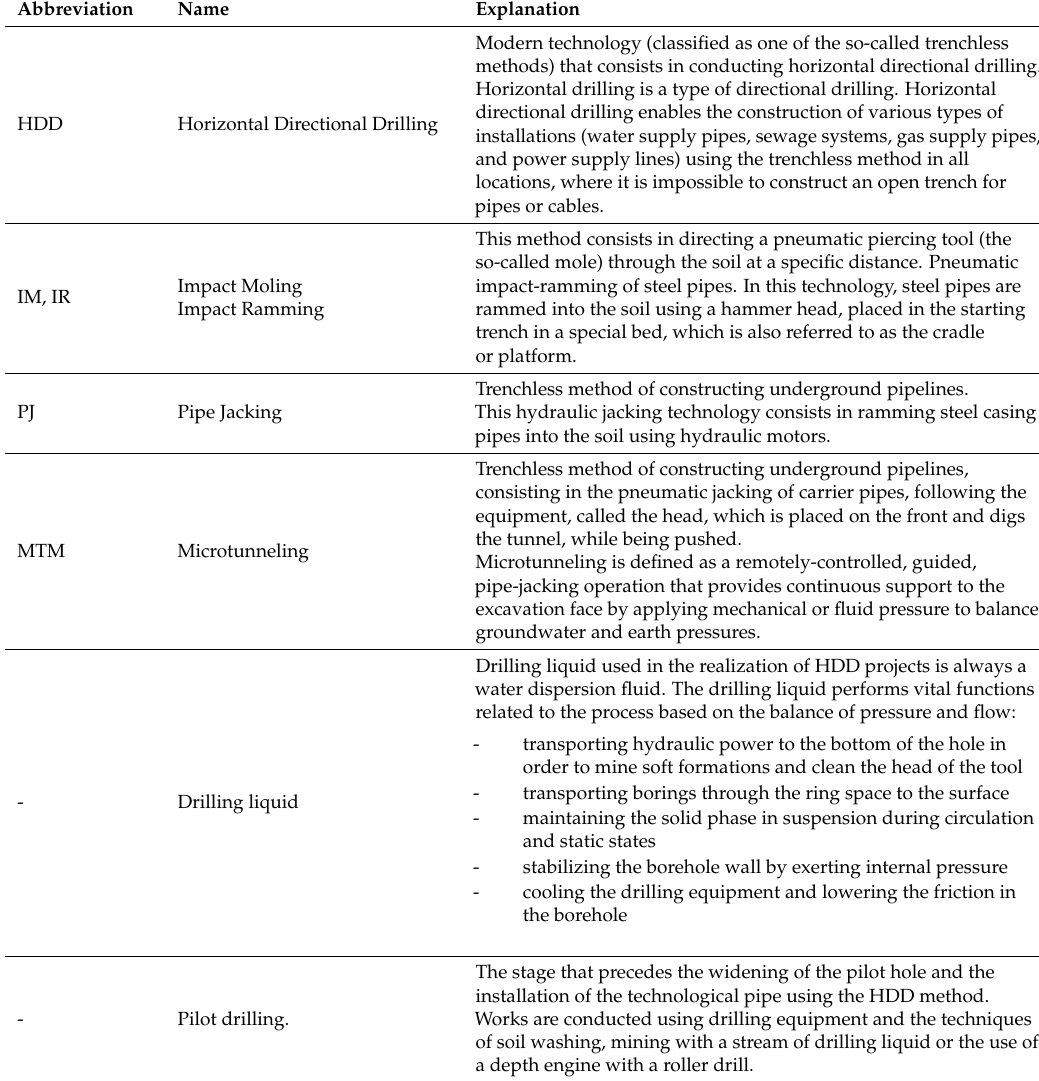
Table 1. The basic and specialist definitions of the terms used in the